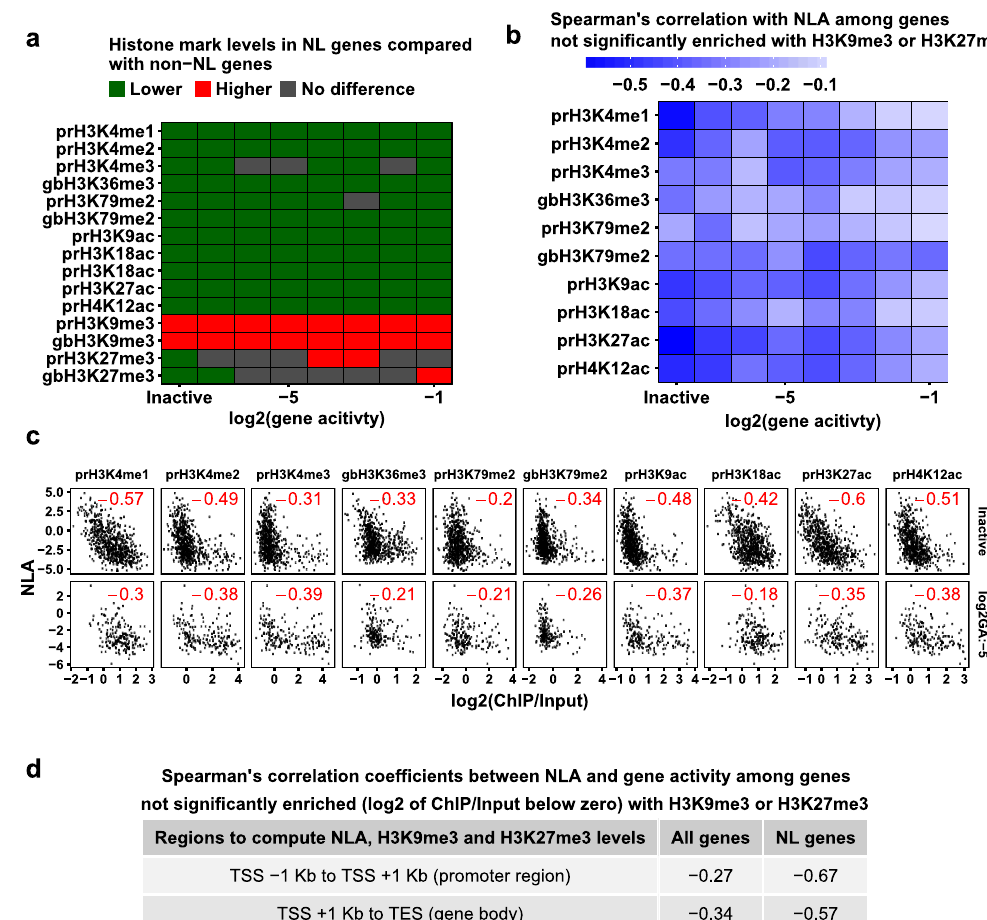
Figure 6. Anti-correlations between NLA and active histone marks or gene activity. ( a ) The heat map displaying comparisons of histone mark levels between NL and non-NL genes grouped by gene activity. Colours indicate that histone mark levels are higher (red), lower (green) or not significantly different (grey) among NL genes compared to non-NL genes as revealed by Mann-Whitney test (cut-off FDR at 0.05). Gene activity groups are defined by rounding log2 of gene activity (RPK m M) to the nearest integer. Each analysed group has 53 NL genes and 451 non-NL genes at minimum. ( b ) The heat map displaying Spearman’s correlation coefficients between NLA and each active histone mark among genes that are not significantly enriched (log2 of ChIP-Input ratio below zero) with H3K9me3 or H3K27me3 across genic regions. FDRs < 0.05 in all cases. ( c ) Scatter plots of NLA against each active histone mark at selected gene activity levels among genes that are not significantly enriched with H3K9me3 or H3K27me3. Spearman’s correlation coefficients are shown in red. In panels b and c, gene activity groups are defined as in panel a. The analysed groups have 173 genes at minimum. ( d ) A table showing negative correlations between NLA and gene activity among all genes or NL genes not significantly enriched with H3K9me3 or